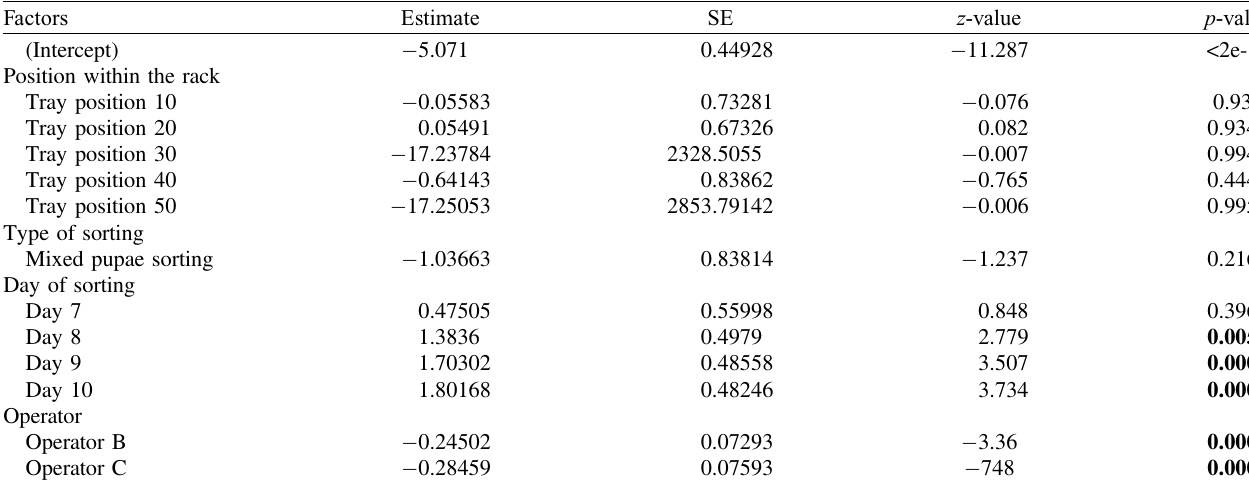
Table 3. Results of the binomial generalized linear mixed model for the effect of day of sorting, tray position in the rack, type of sorting, and the operator on female contamination rates in male pupae using the Fay – Morlan glass plate separator. Factors